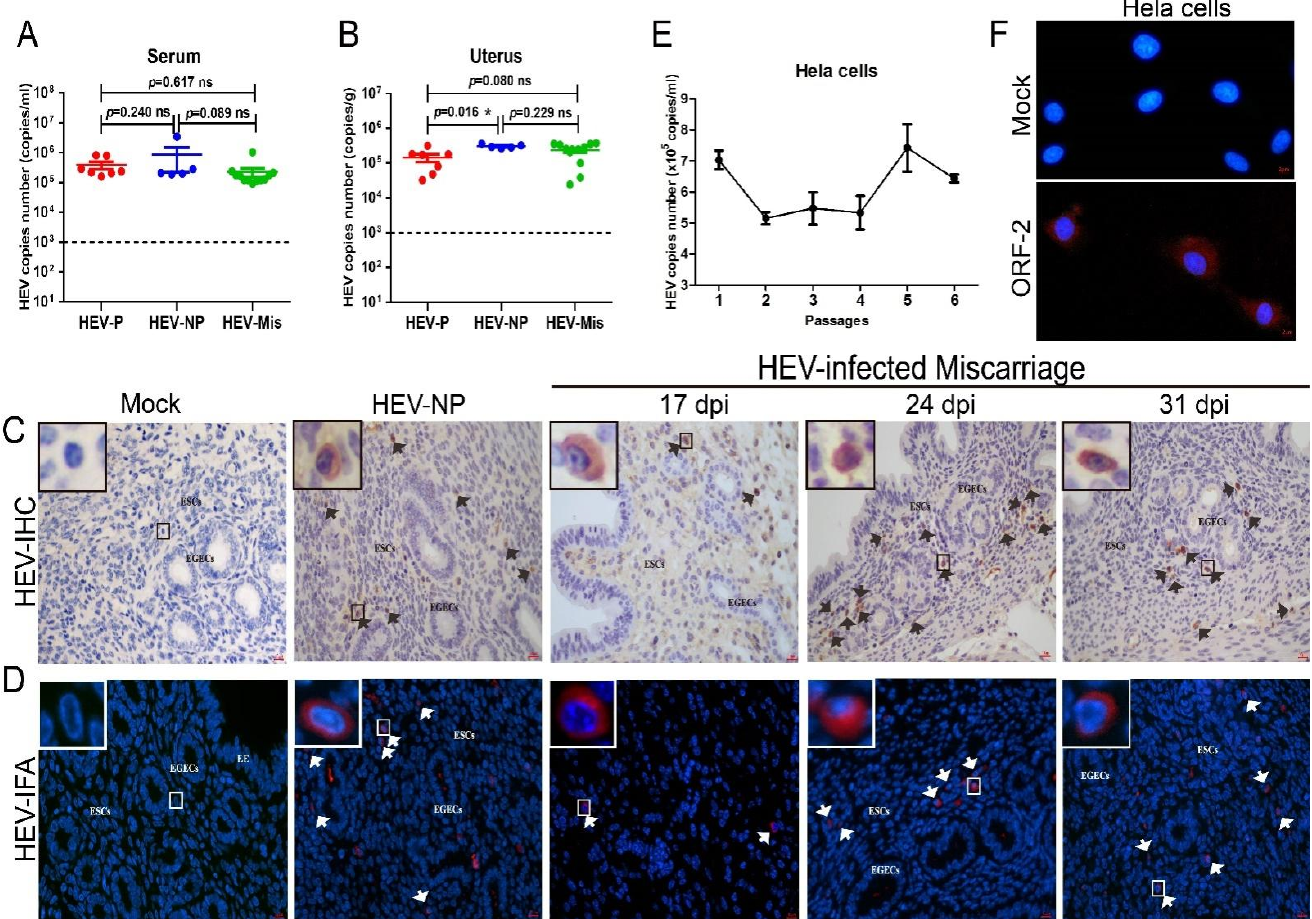
Figure 2. HEV replicates in the uterus. HEV RNA detected in the serum ( A ) and uterus ( B ) of HEV ‐ infected mice and quantitated by qRT ‐ PCR. The copy numbers of HEV RNA in the serum and uterus were compared and analyzed by using IBM SPSS Statistics 21 software. * p < 0.05. HEV antigens detected in the uteruses of mock or HEV ‐ infected mice by IHC ( C ) and IFA ( D ). ESCs: endometrial stromal cells; EGECs: endometrial gland epithelial cells. ( E ) HEV titer in HEV ‐ inoculated Hela cells determined by qRT ‐ PCR. ( F ) HEV antigens (red) observed in mock or HEV ‐ infected Hela cells by IFA with a HEV ‐ specific antibody. Nuclei stained by DAPI (blue).